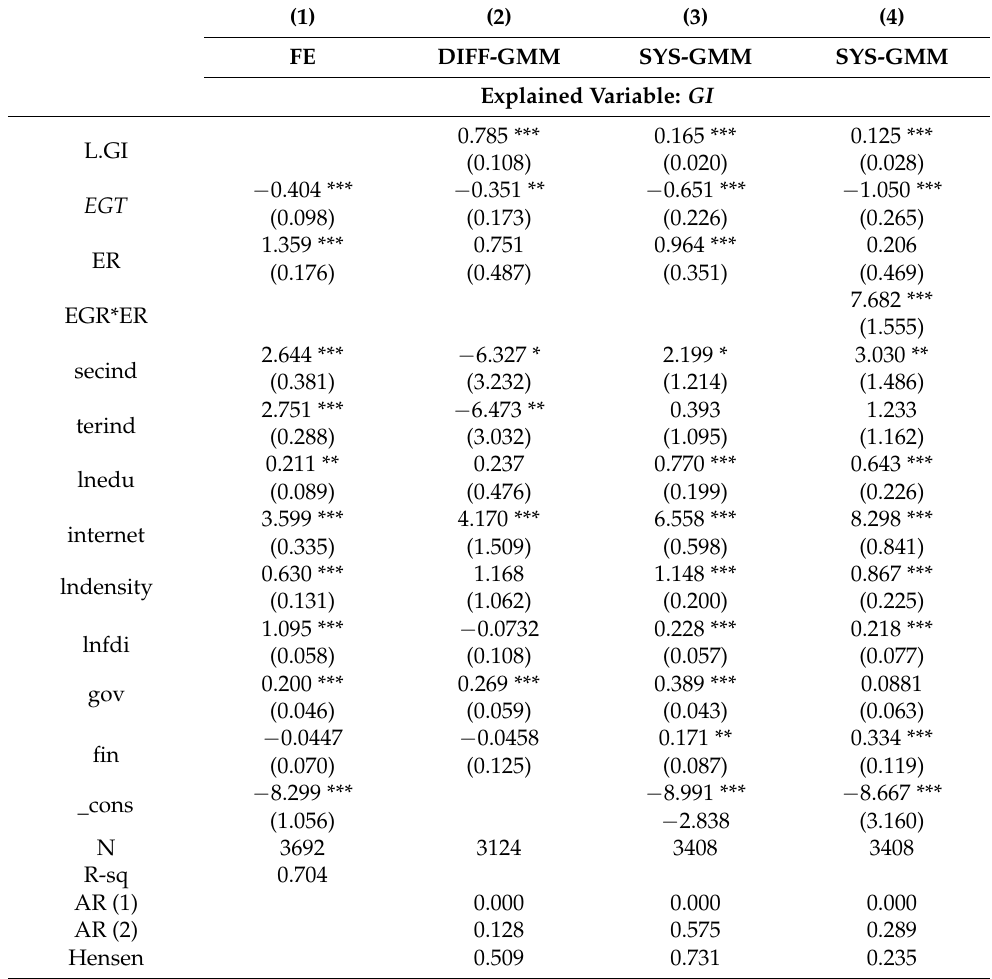
Table 2. Benchmark regression